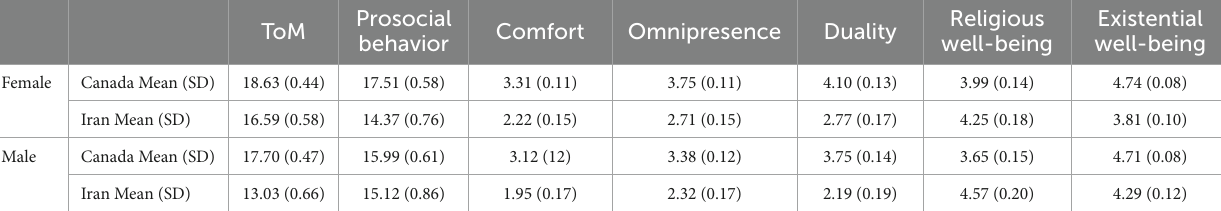
TABLE 3 Descriptive statistics of gender * culture.